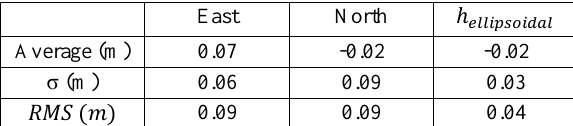
Table 2. Statistics on the differences for GCPs coordinates